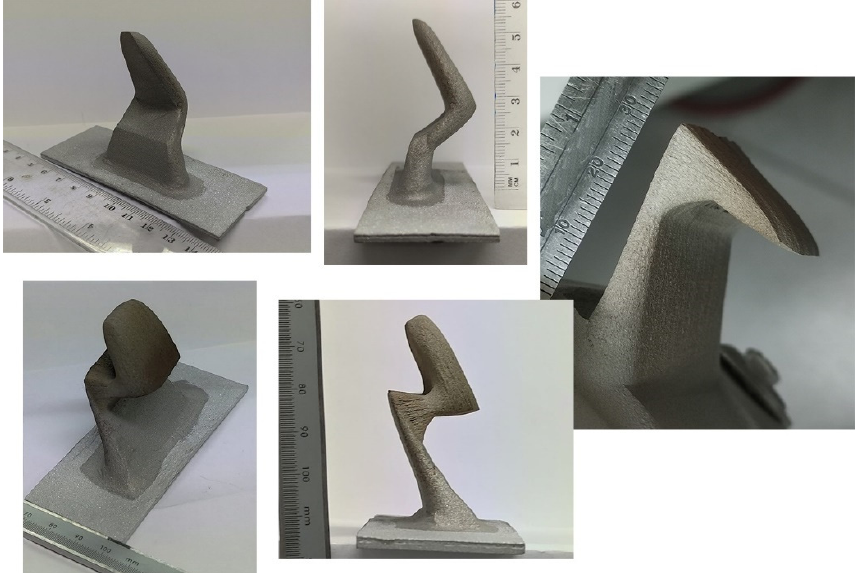
Figure 14. CSAM 316L complex geometries made by the Metal Knitting strategy.